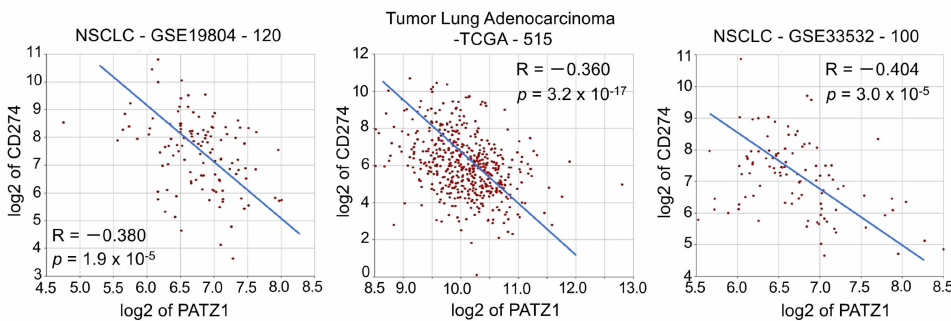
Figure 4. PATZ1 and CD274 expression are inversely correlated. XY-dotplots showing the correlation between PATZ1 ( X -axis) and CD274 ( Y -axis) gene expression in three publicly available NSCLC gene expression datasets analyzed via the R2: Genomic Analysis and Visualization platform [36].